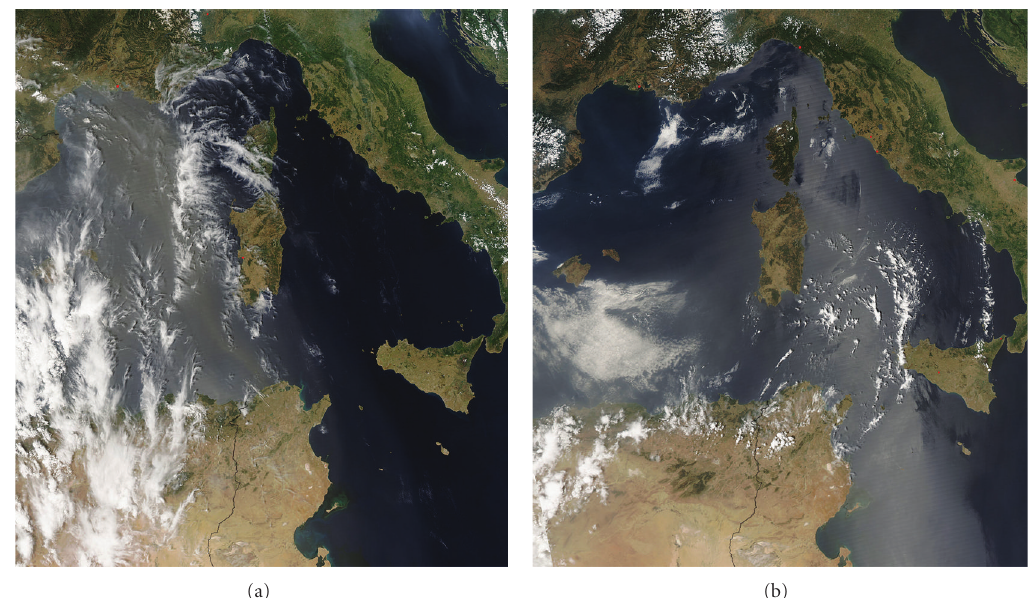
Figure 3: MODIS/AQUA images for 15 June (a) and 26 June (b)